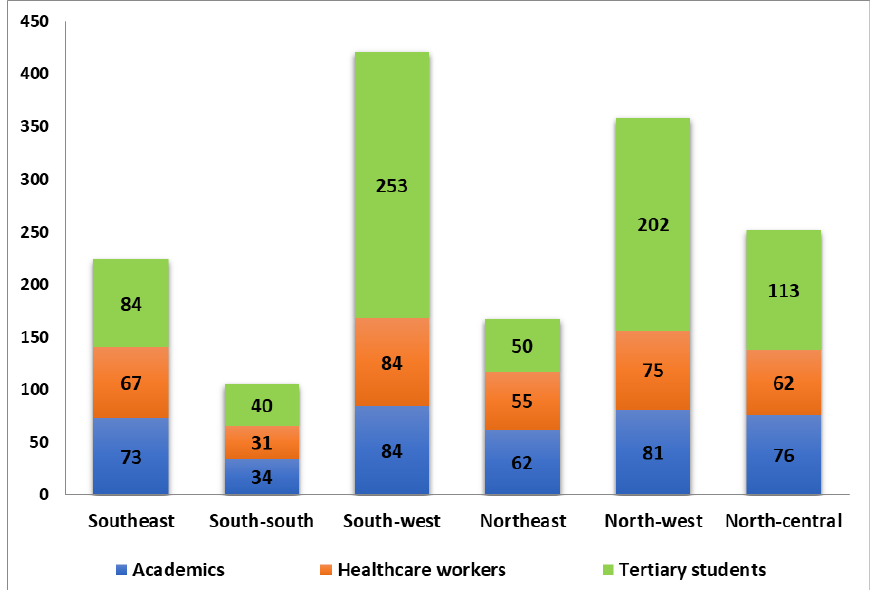
Figure 4. Distribution of the number of respondents (academics, healthcare works and tertiary stu- dents) surveyed for COVID-19 vaccine hesitancy across the six geopolitical zones of Nigeria. Only 27.1% (401/1525) of the respondents had tested positive (i.e., by PCR) for SARS- CoV-2 infection (Figure 5). Other details, as well as information on exposure of the